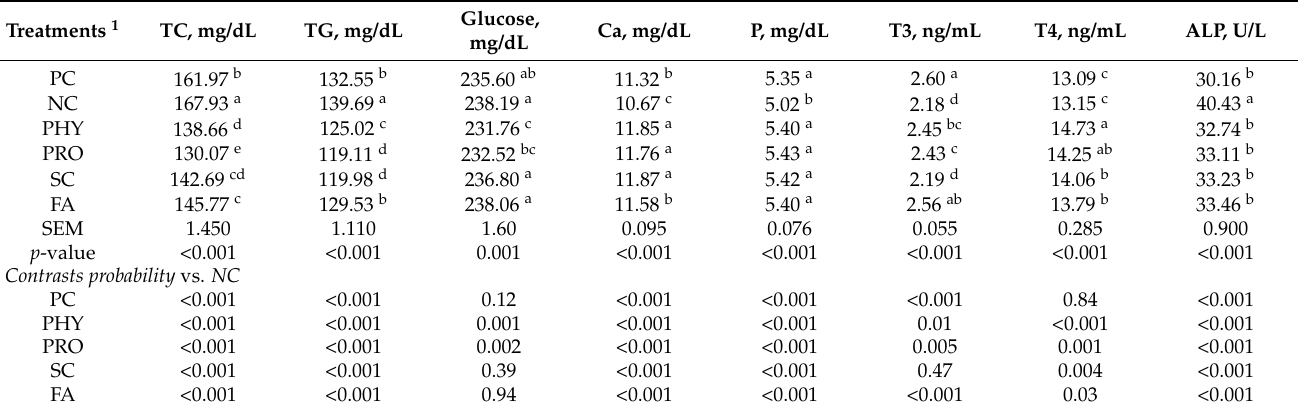
Table 7. Serum constituents and hormone profile of broiler chickens fed a reduced nPP diet supple- mented with phytase, probiotic, Saccharomyces cerevisiae , and fumaric acid at 35 days of age.